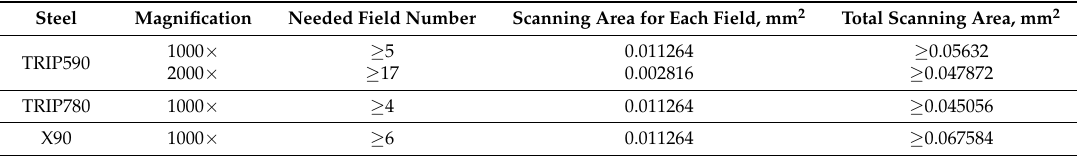
Table 7. The needed field number and scanning area for different steels.